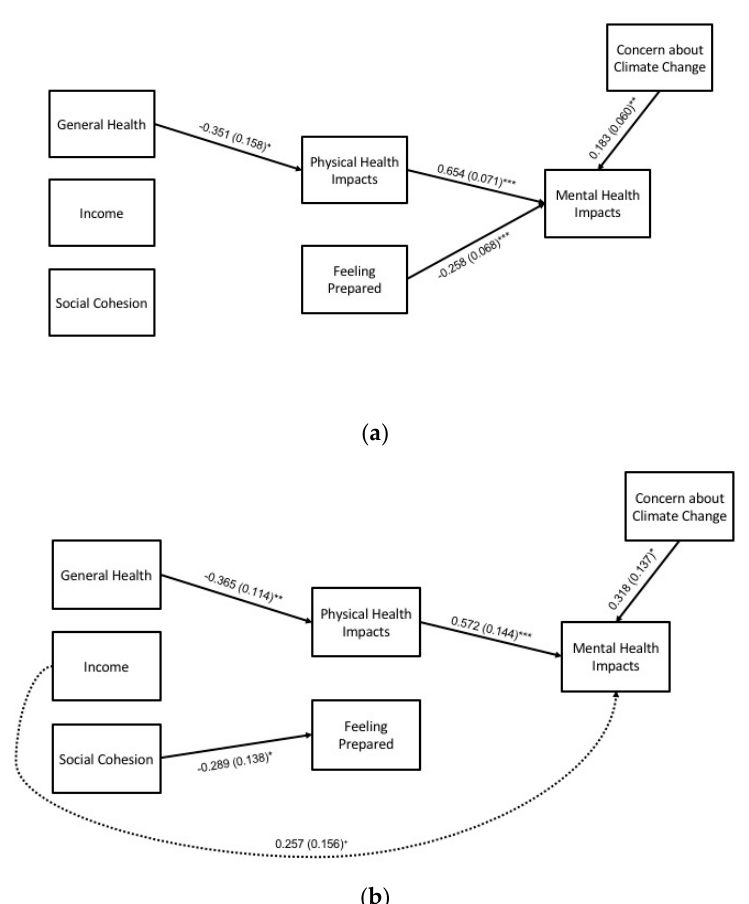
Figure 5. Path model for mental health impacts during winter extremes ( N = 397), by racial subgroup: ( a ) White ( n = 308), and ( b ) Black ( n = 89) participants. Statistically significant pathways are shown with standardized estimates and standard errors (SEs) in parentheses. Statistical significance levels are: + p < 0.10, * p < 0.05, ** p < 0.01, and *** p < 0.001.